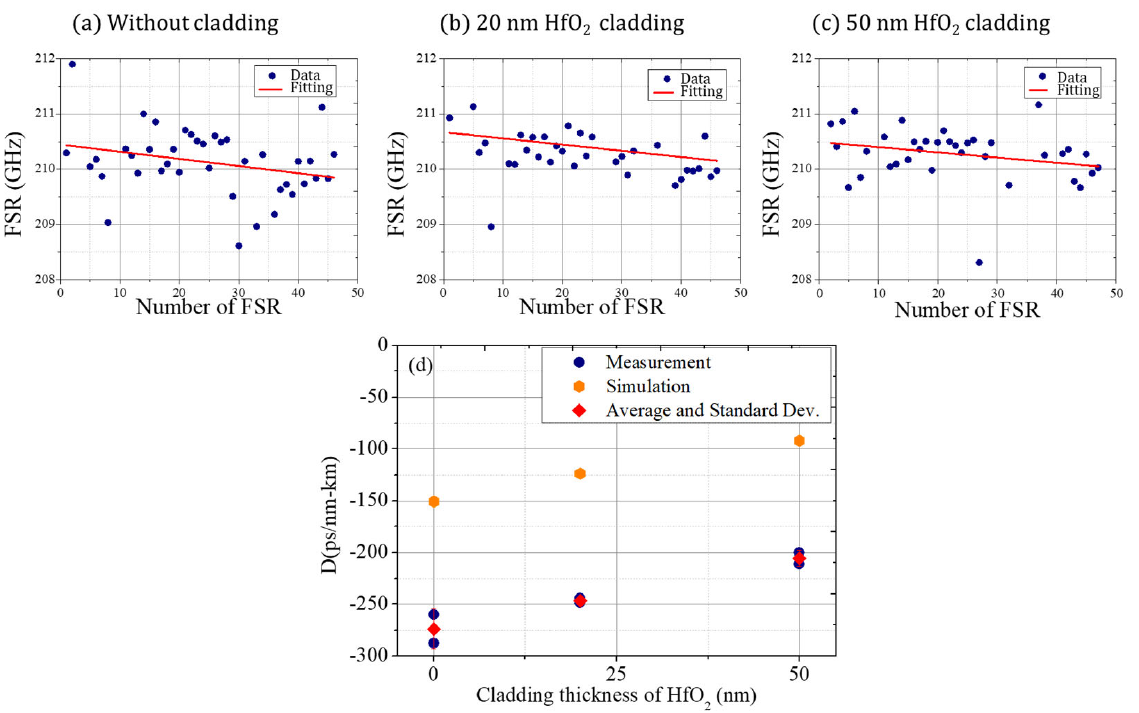
Figure 6. Evolution of FSRs for ( a ) air-cladded, ( b ) 20 nm, and ( c ) 50 nm HfO 2 cladded devices. ( d ) The measured waveguide dispersion versus the cladding thickness of HfO 2 cladding.